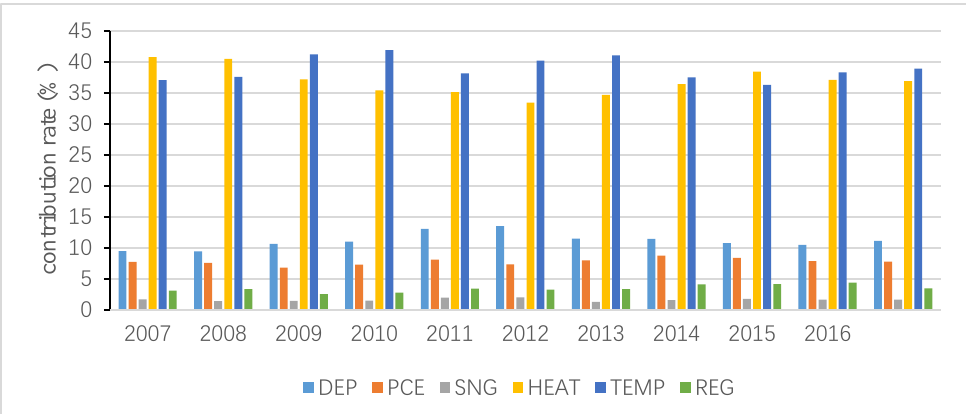
Figure 4. Decomposition result of urban residential energy consumption per capita (URECP) by Gini coefficient.